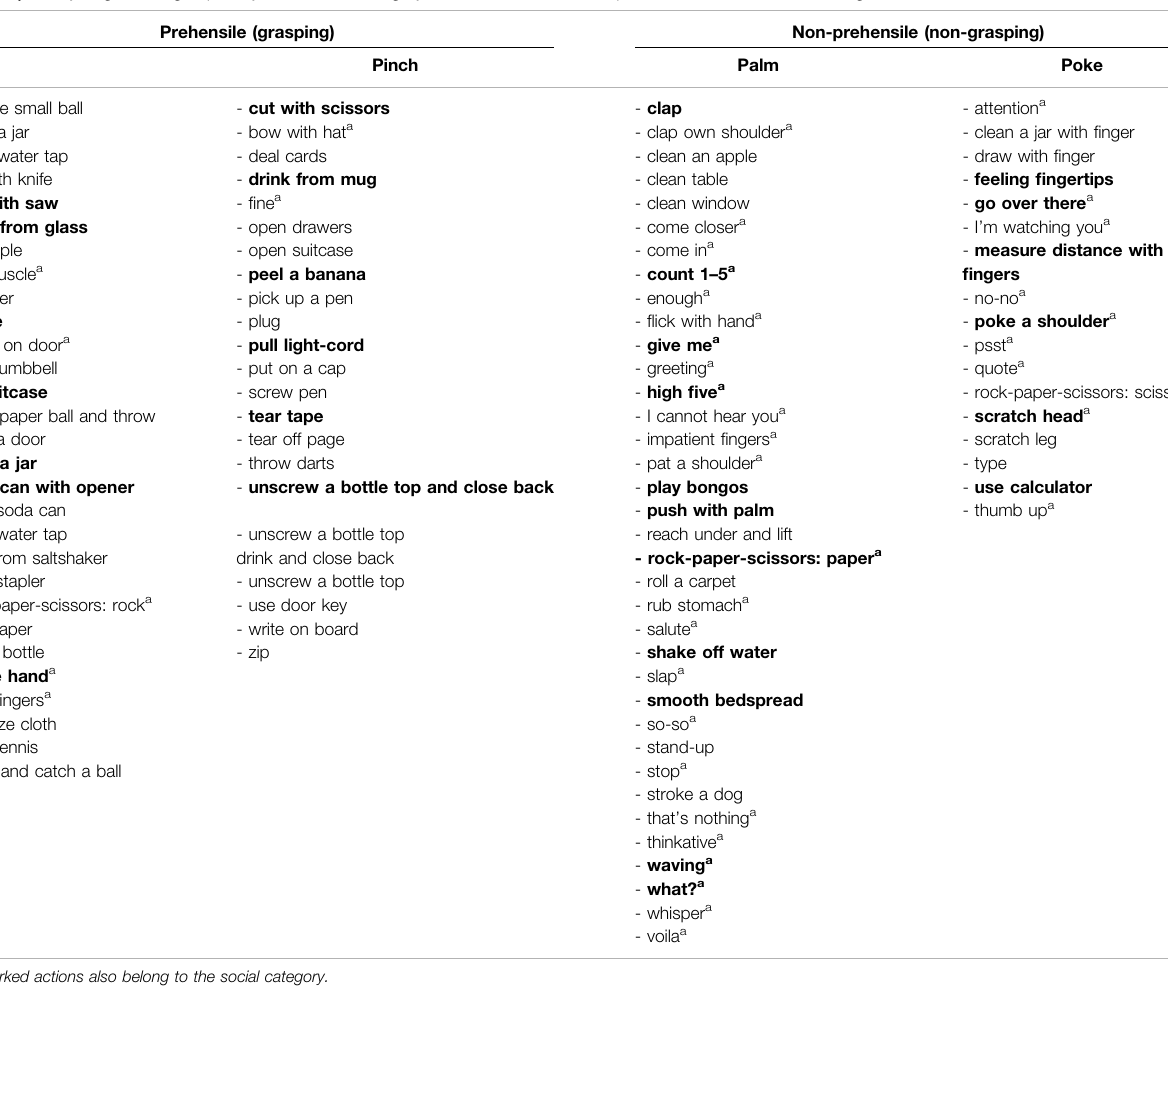
Frontiers in Robotics and AI |